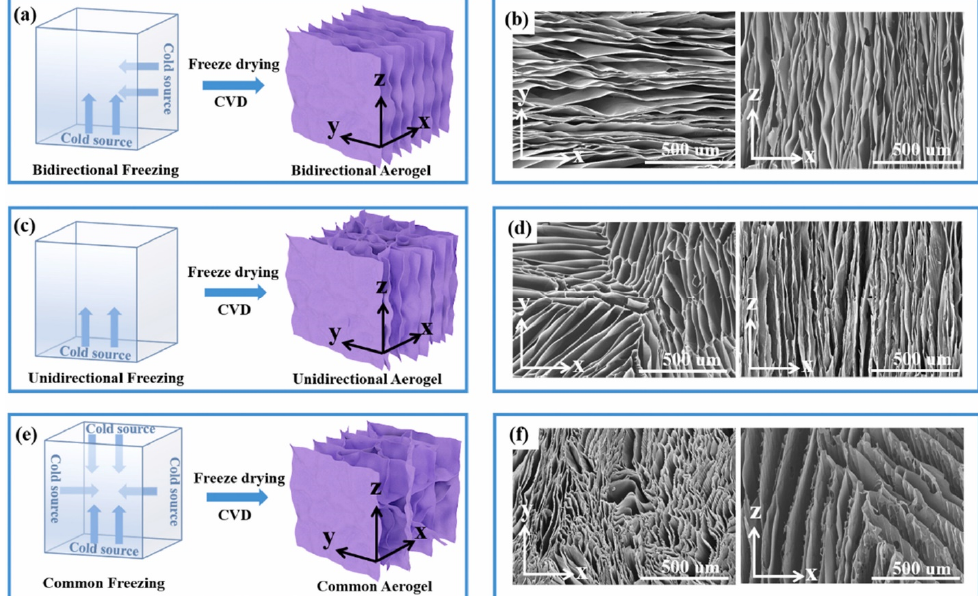
Figure 9. ( a ) Schematic illustration of bidirectional freeze casting aerogel composites, ( b ) SEM images for the cross section (x-y plane) and longitudinal section (x-z plane) of the bidirectionally freeze cast aerogel composite, ( c ) schematic illustration of unidirectional freeze casting aerogel composites. ( d ) SEM images for the cross section (x-y plane) and longitudinal section (x-z plane) of the unidirectionally cast aerogel composite. ( e ) Schematic illustration of the ordinary freeze casting aerogel composite. ( f ) SEM images for the cross section (x-y plane) and longitudinal section (x-z plane) of the commonly freeze cast aerogel composite. Reproduced with permission from [16], ©2020 Elsevier B.V.